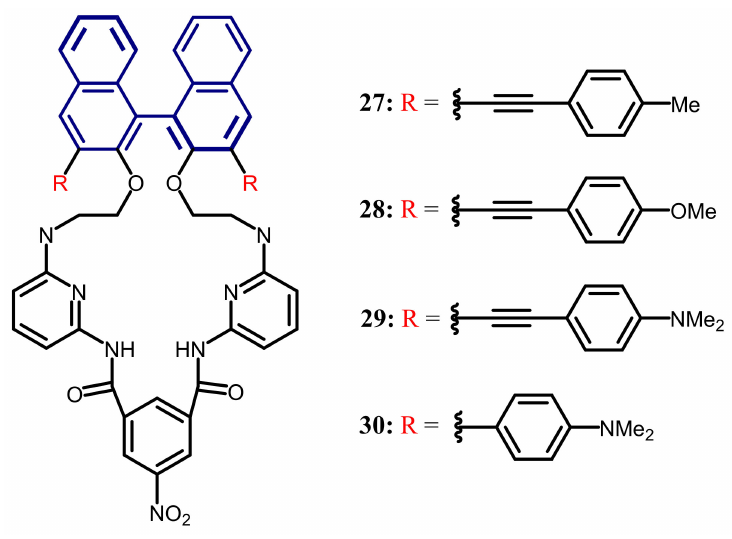
Figure 11. The chemical structure of 27 , 28 , 29, and 30